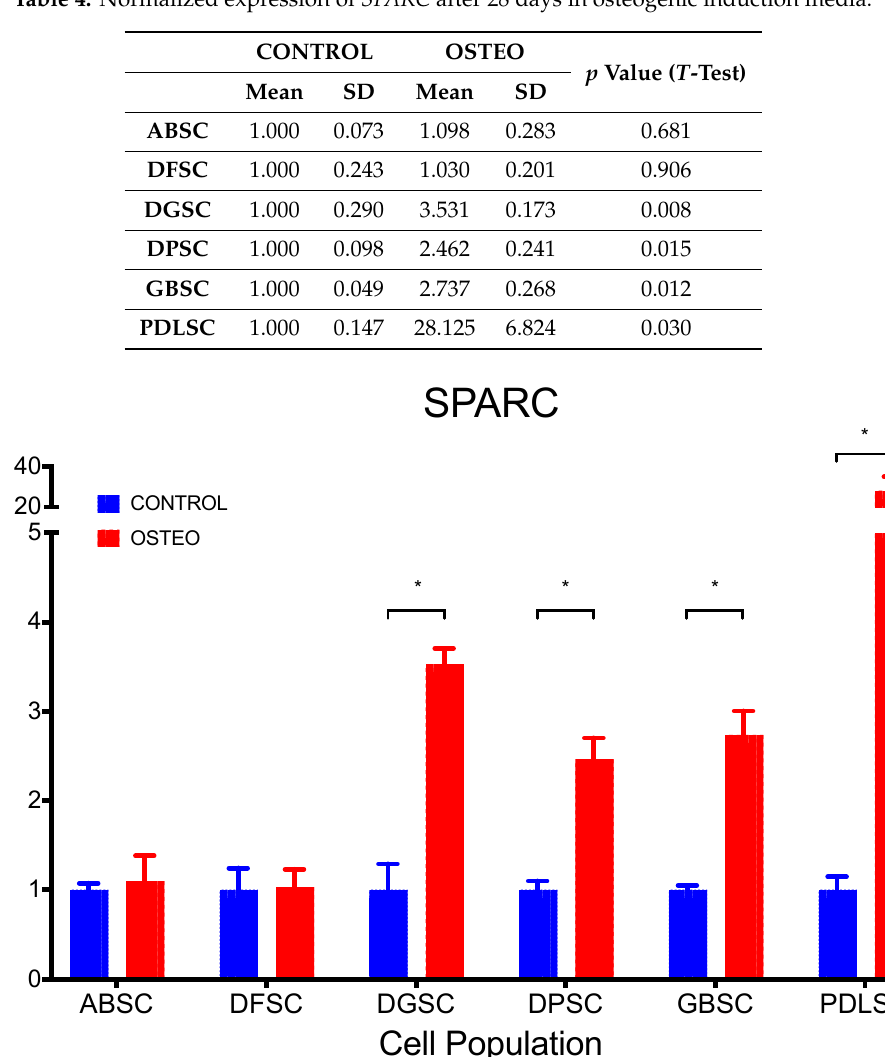
Table 4. Normalized expression of SPARC after 28 days in osteogenic induction media.